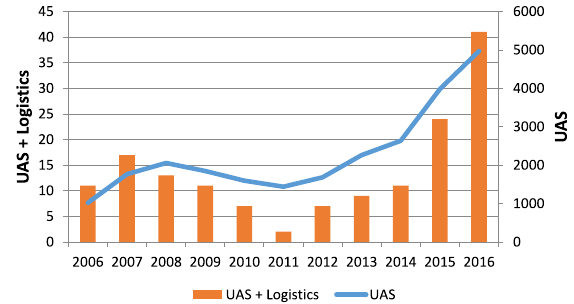
Figure 2 Total number of articles including the terms UAS and